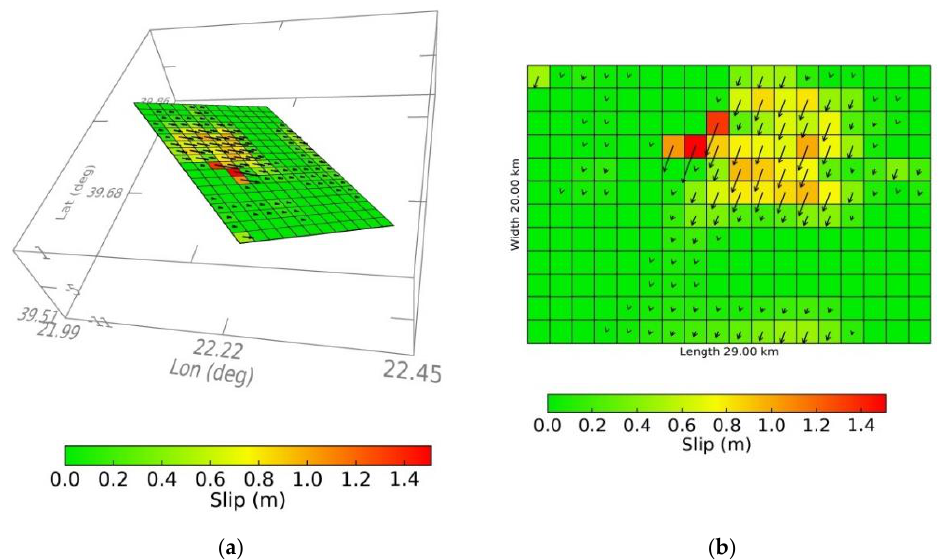
Figure 11. Modelled geodetic seismic fault for the first shock of 3 March 2021 in ( a ) 3D illustration and ( b ) vertical profile along strike (SE–NW).